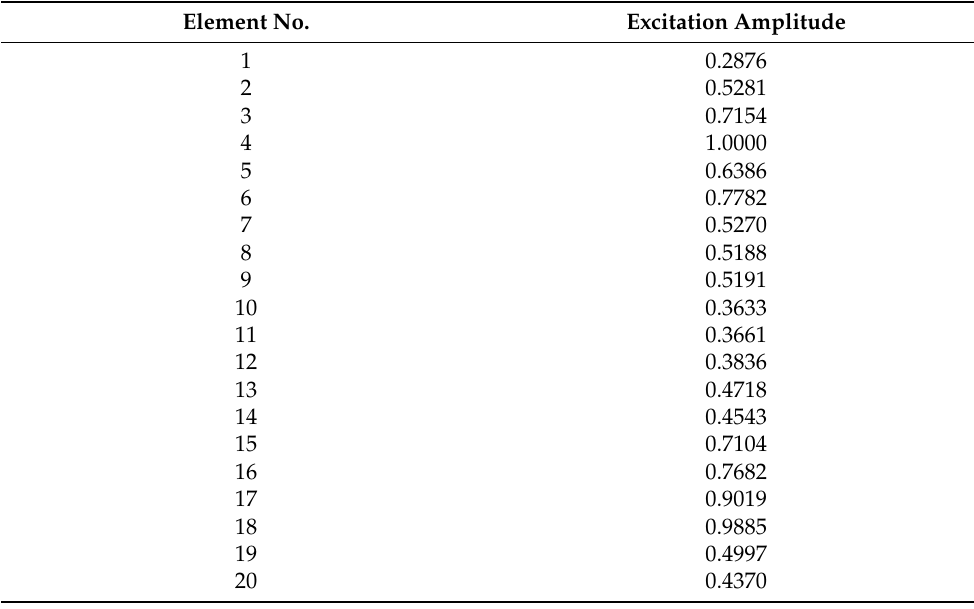
Table 10. The best normalized value of the magnitude of the excitation current using FKE algorithm for anti-jamming optimization. Element